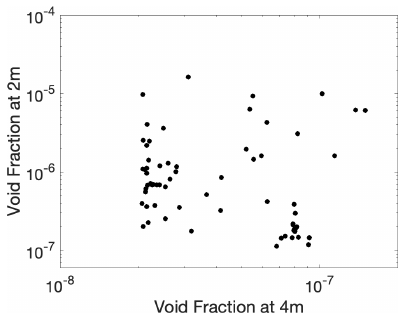
Figure 4. Scatter plot comparing 1min average void fractions at 2 and 4m during station 6 (1–4 November). All periods when the data at 4m were above the noise level are